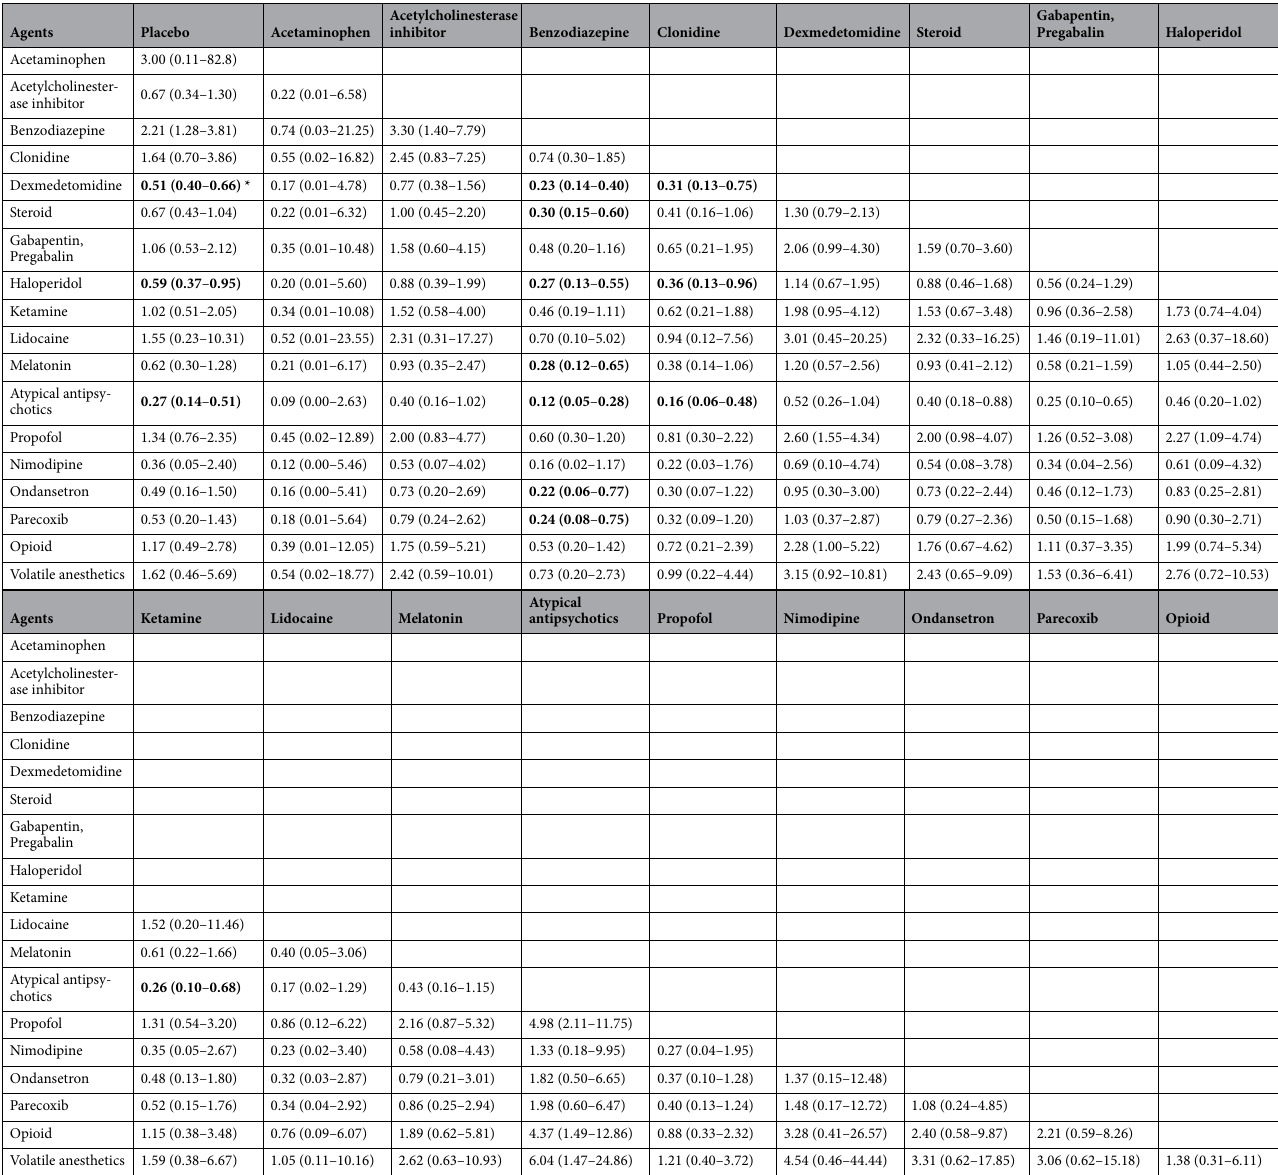
Table 2. Network pooled estimates for the incidence of delirium in all pairs of comparisons. Data are shown as odds ratio (95% credible interval). Column intervention (numerator) was compared to row interventions (denominator) for the incidence of delirium after surgery. For example, *dexmedetomidine versus placebo for the incidence of